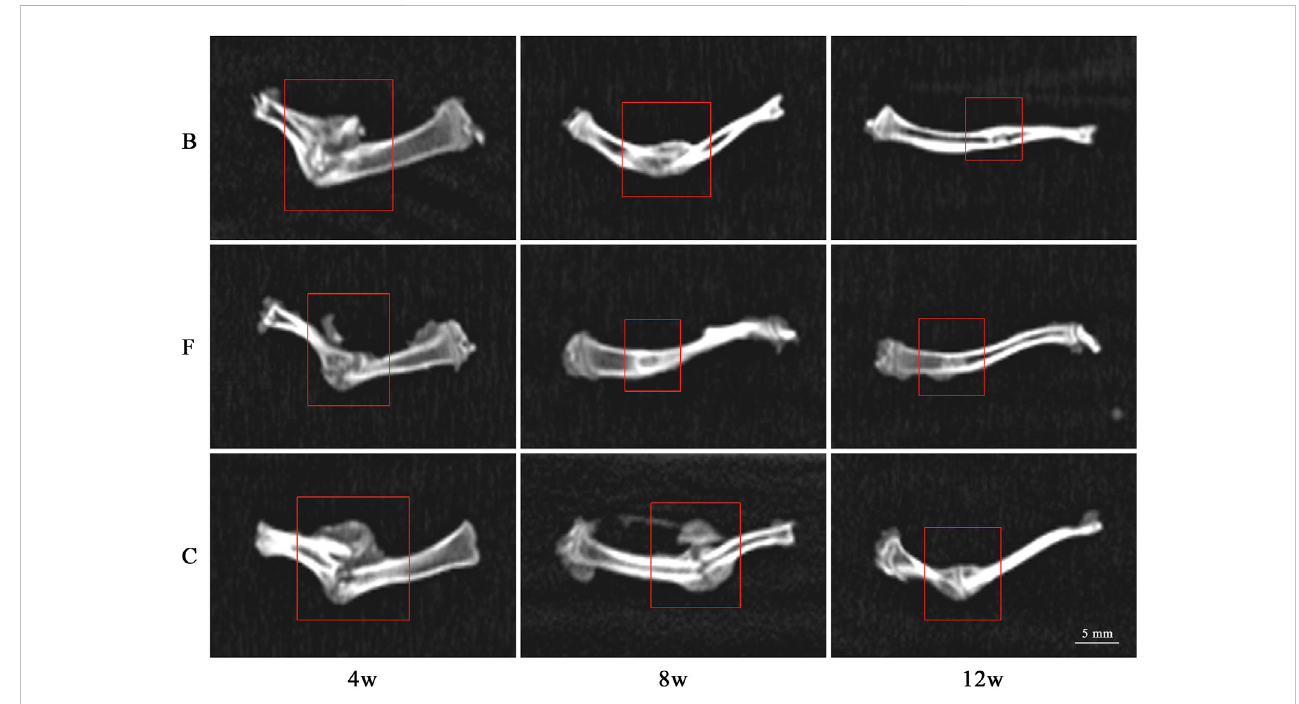
FIGURE 12 CT radiographic observation (B: BDBM group; F: FDBM group; C: Self-healing group).